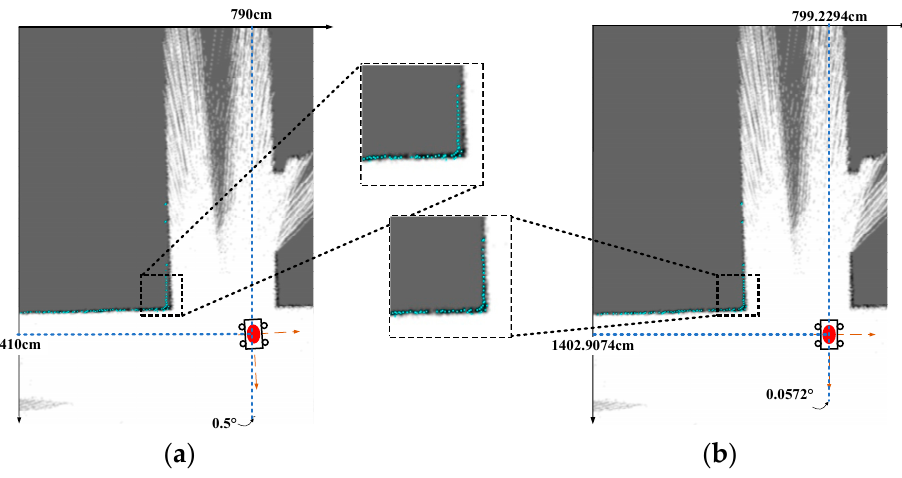
Figure 14. Mapping between scan points and grid map under the ( a ) initial pose; ( b ) the pose from the proposed NLO-CSM hardware accelerator.